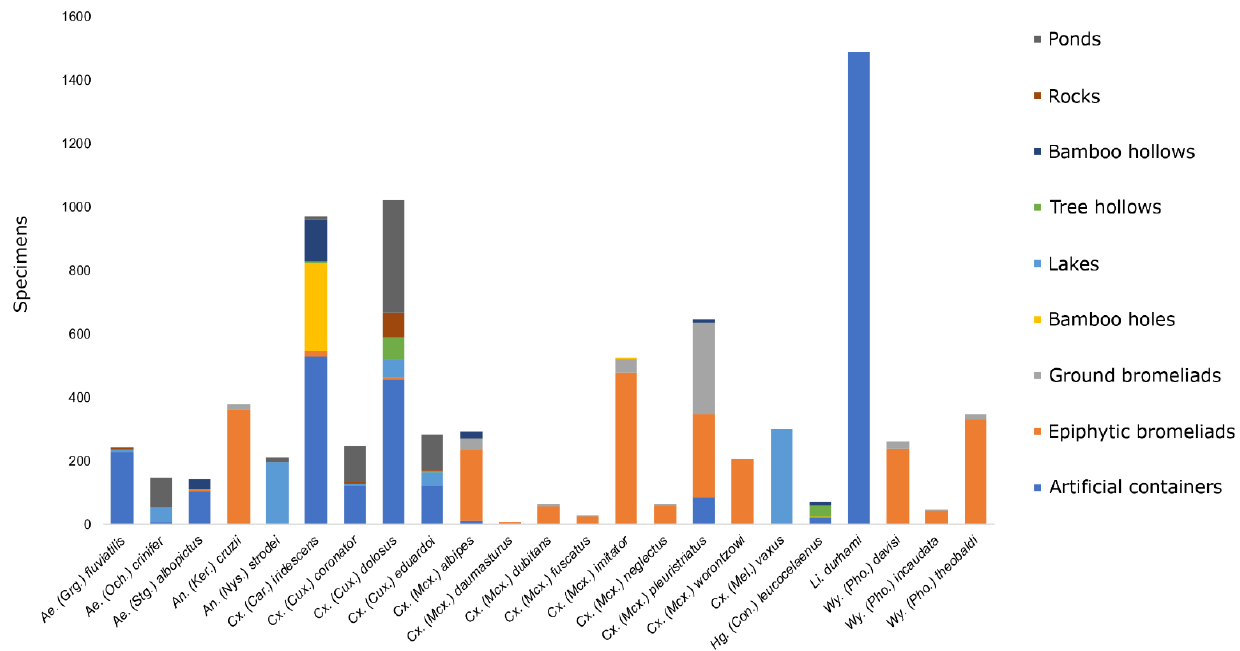
Figure 1. Community composition of immature mosquitoes collected in the aquatic habitats in two Atlantic Forest remnants in the city of São Paulo, Brazil, surveyed from February 2015 to April 2017.